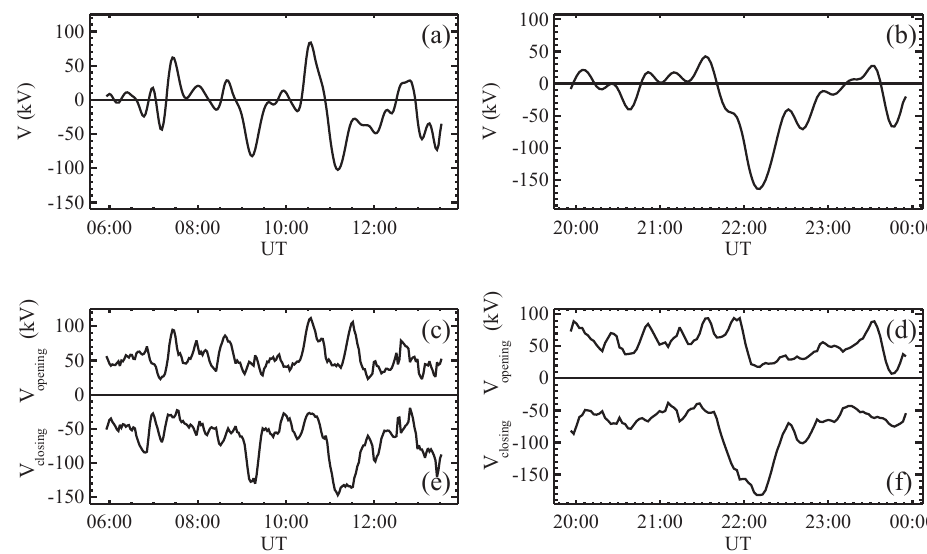
Figure 8. Reconnection voltages estimated using SI12 observations of the proton aurora and SuperDARN measurements of the ionospheric convection on 21 August 2000. The net reconnection voltage (a) and (b) results from the imbalance between the rate of magnetic flux opening (c) and (d) and closure (e) and (f) .